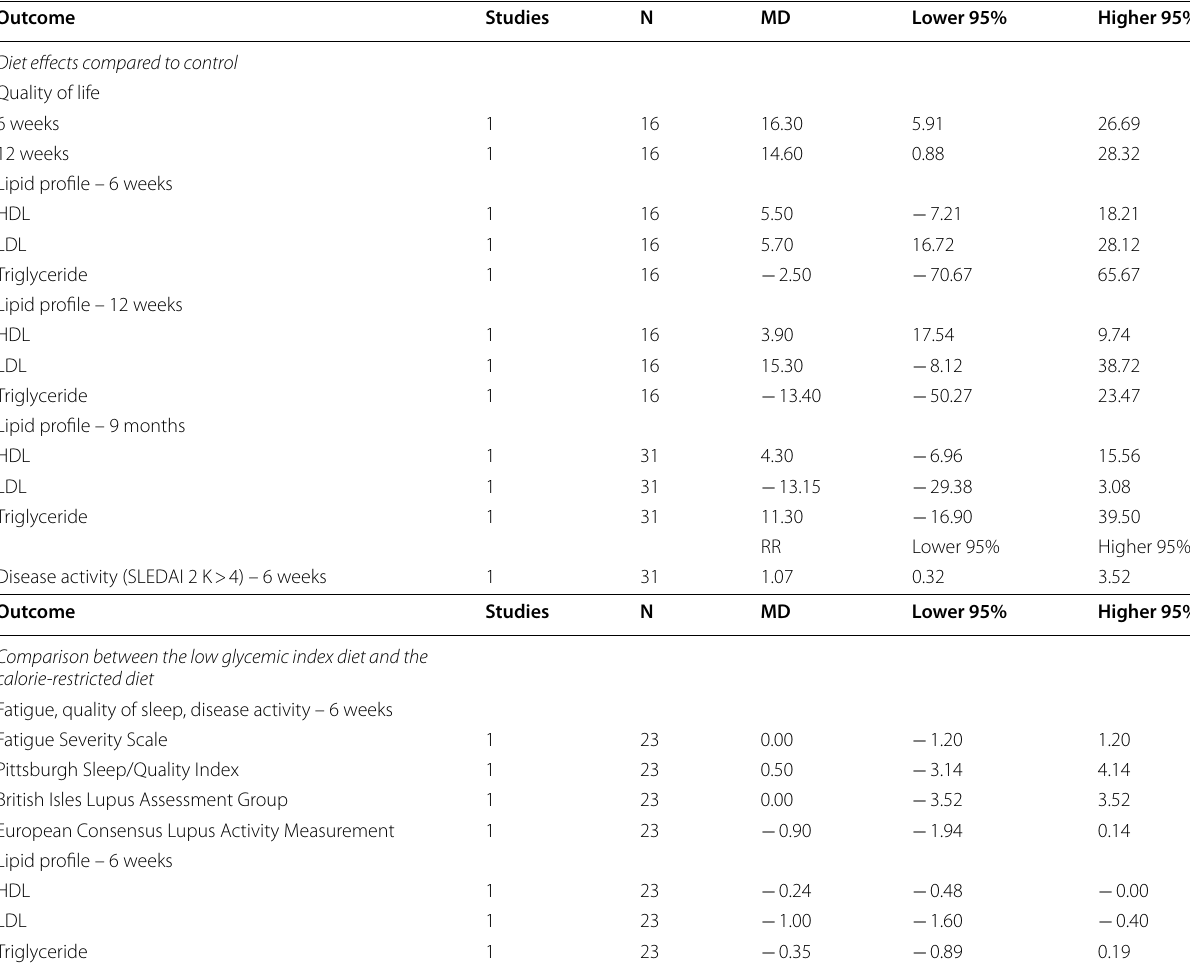
Table 3 Post-intervention values of estimated effects for all outcomes